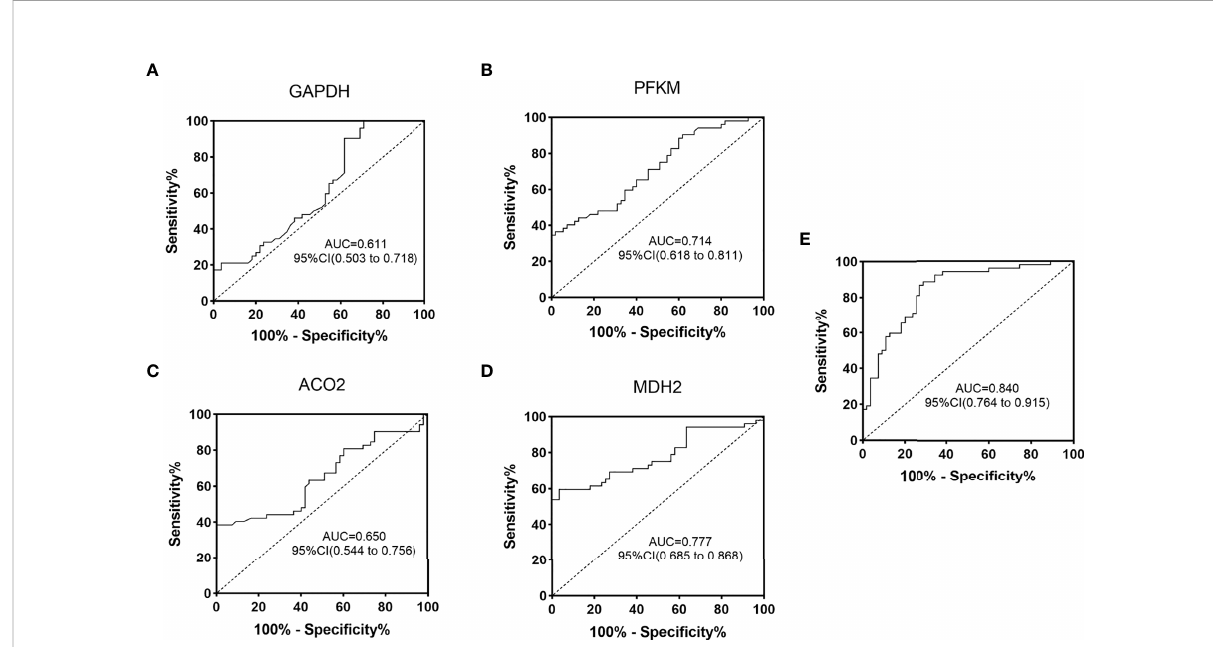
FIGURE 6 ROC curve analysis of oxygenation-related proteins in urinary exosomes in monitoring of diabetic patients. ROC curves were drawn according to the protein concentration in the urine exosomes of diabetic group (DM) and normal control group (NC) measured by ELISA. GAPDH (A) , PFKM (B) , ACO2 (C) , MDH2 (D) and the combined ROC curve of the four proteins (E) . AUC, area under the curve; CI, con fi dence